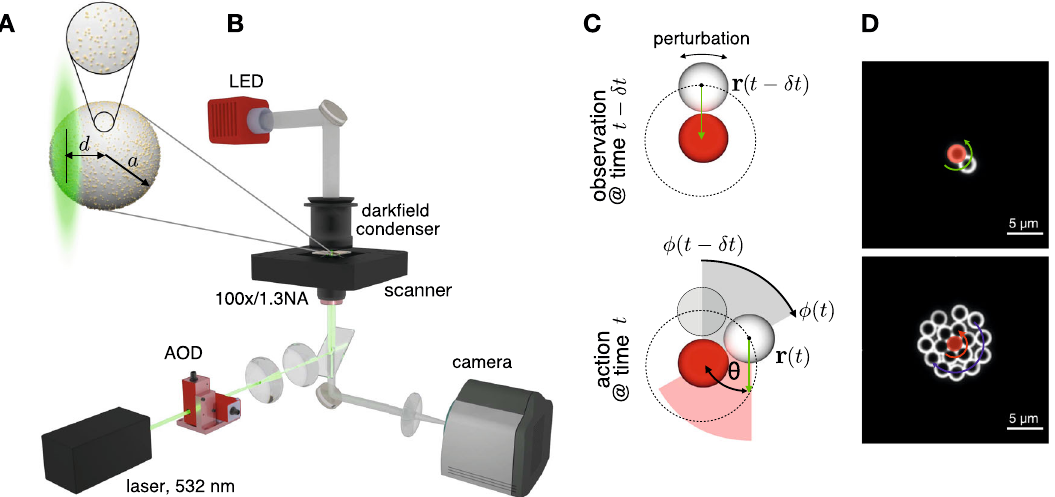
Fig. 1 | Experimental realization. A Particles used in the experiments consist of a melamine resin colloid (2.18 μ m in diameter) with 8nm gold nanoparticles scat- tered across the surface (covering up to 10% of the total surface area). A 532nm laserfocusedattheedgeoftheparticleatadistance d fromitscenterinducesaself- thermophoretic motion and allows for precise control ofthe propulsiondirection. Importantly, optical forces are weak so the particles exhibit a truly self-phoretic autonomous motility, making them proper microswimmers. B Experimental setup usedtoimagetheparticlesbydark fi eldmicroscopy(LED,dark fi eldcondenser,and camera) and guide their motion by sequential beam steering of the laser on the